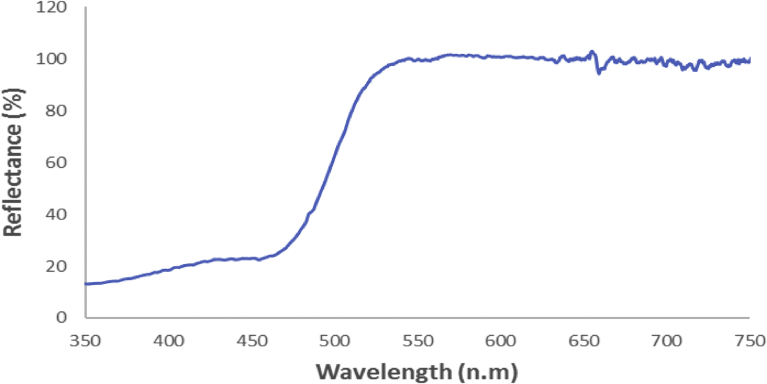
UV-Vis diffuse reflectance spectra of Ag3PO4.